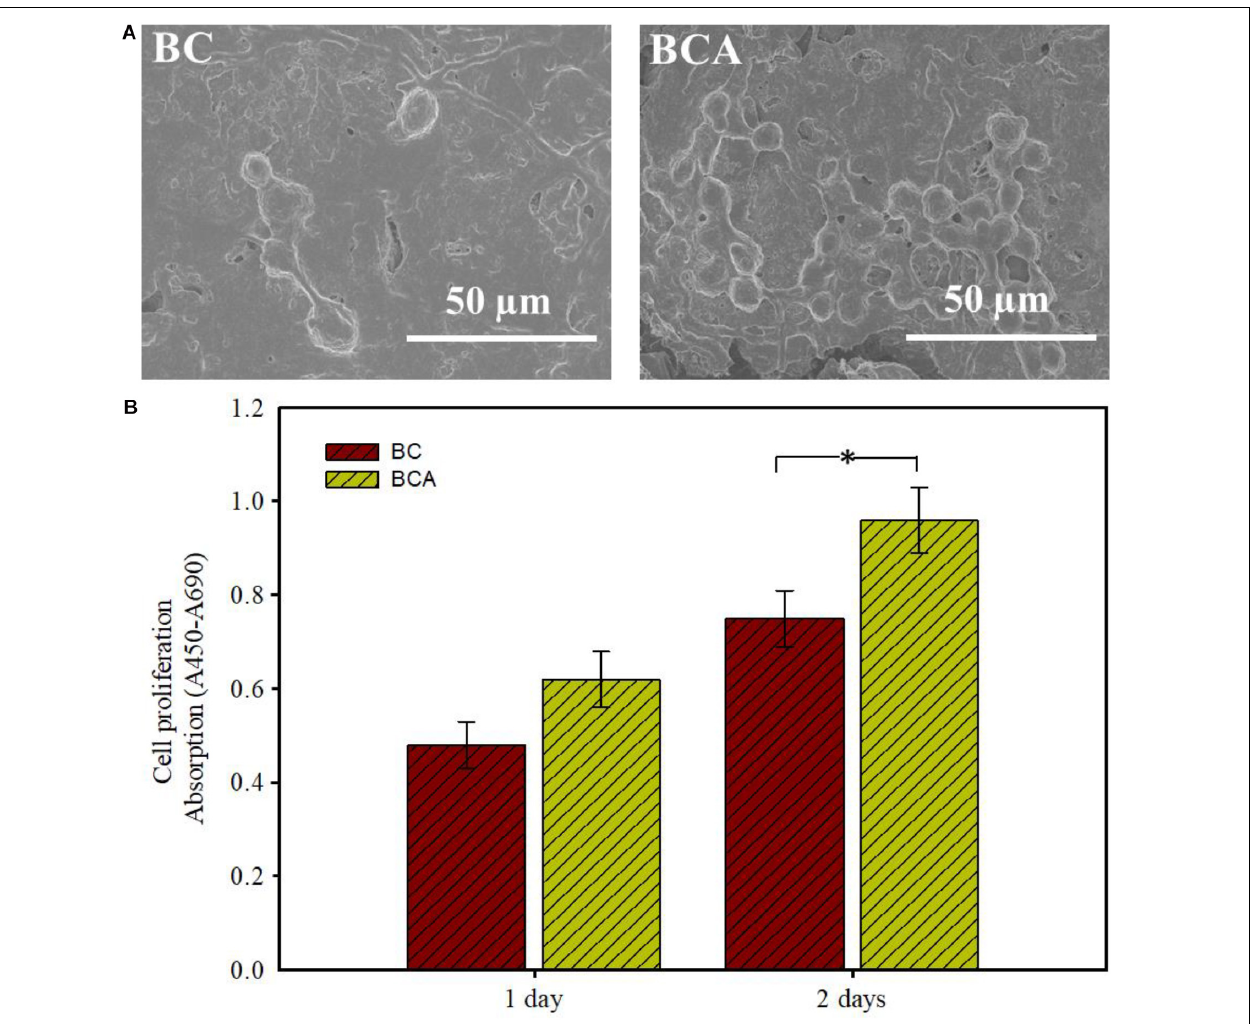
FIGURE 7 | Cytocompatibility analysis of pristine BC and ex situ developed Aloe vera -loaded-BC composite (i.e., BCA). (A) The adhesion and structural morphology of MC3T3-E1 cells on both samples was observed under FE-SEM. (B) The proliferation of MC3T3-E1 cells on the samples was determined by measuring the absorption after 1 and 2 days. The asterisk ( ∗ ) indicates a P -value of < 0.05.